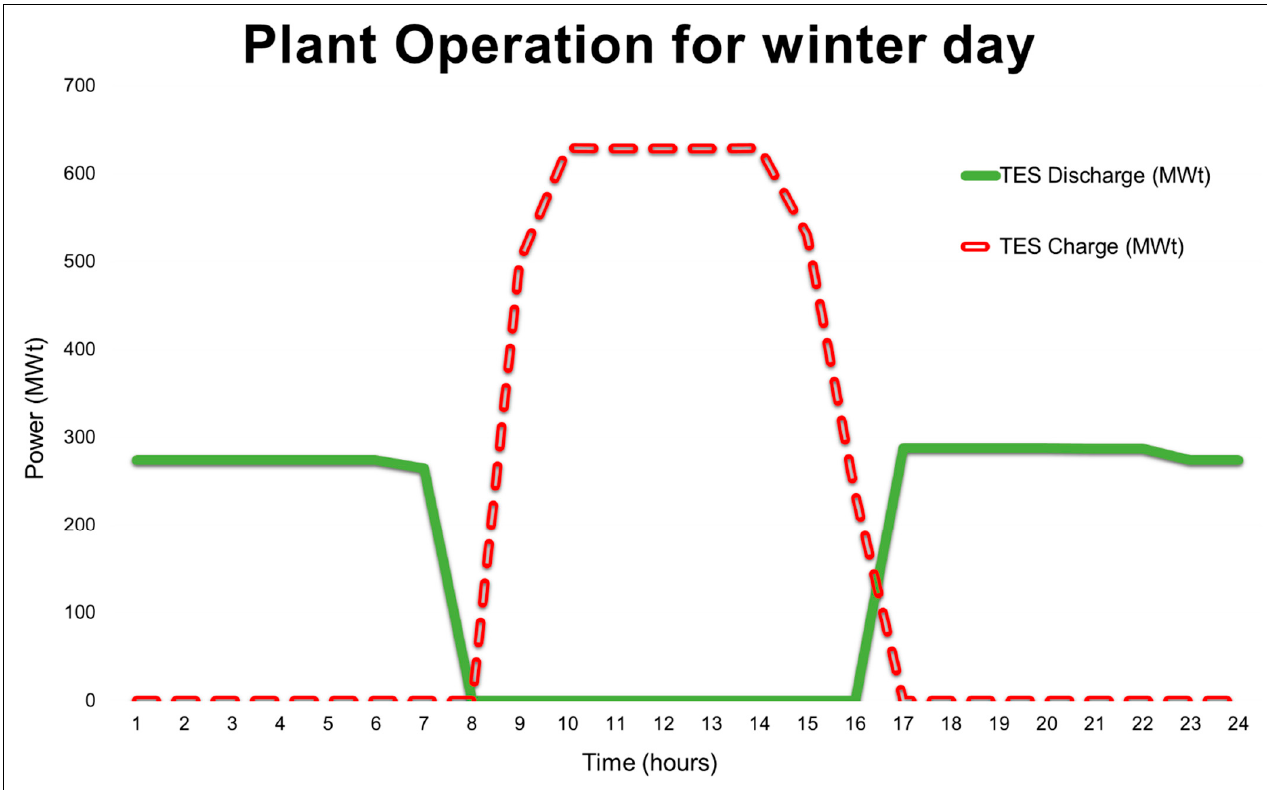
Figure 9. TES load and discharge for a winter day.